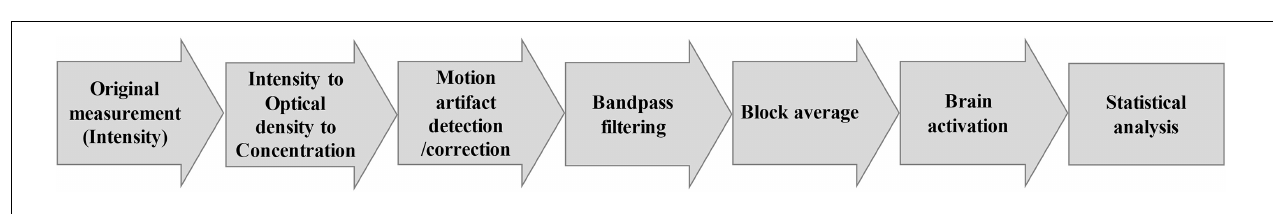
FIGURE 3 | Data processing